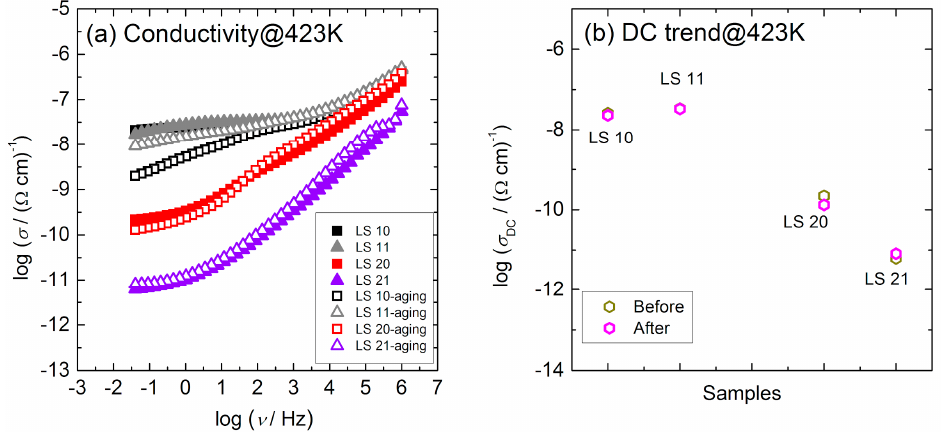
Figure 5. ( a ) Conductivity isotherms and ( b ) DC conductivity of the samples (LS10, LS11, LS20, and LS21) before and after aging obtained at 423 K.